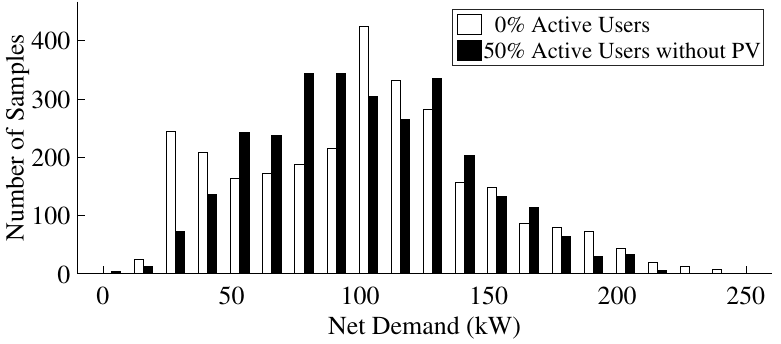
Figure 14. E net for the 50% active customers without PV. k